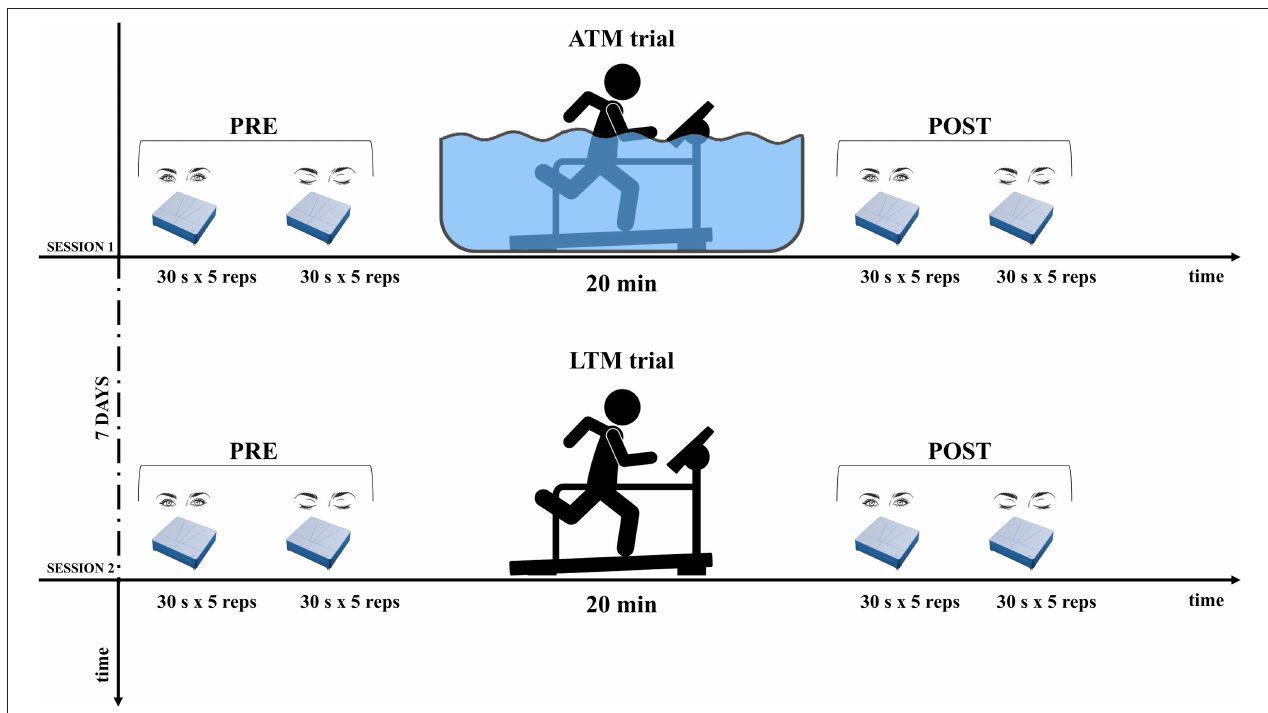
FIGURE 1 | Experimental design. For both opened and closed eyes, postural balance assessment was performed before (PRE) and after (POST) aquatic-treadmill (ATM), and land-treadmill (LTM) trials. Sessions were administered following a cross-over design.